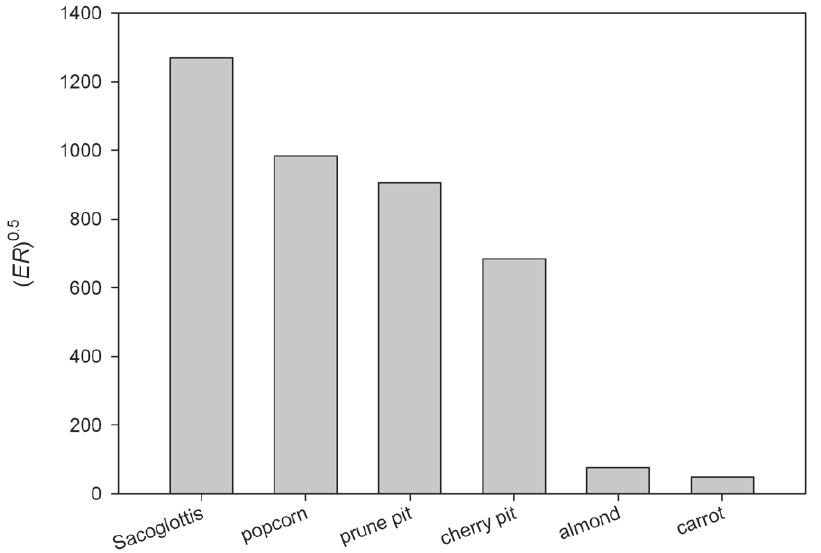
Figure 1. Fragmentation index of Sacoglottisgabonensis compared to familiar food materials. E is elastic modulus (MPa) and R is fracture toughness (Jm 2 2 ). High values indicate stress-limited foods, i.e., those expected to require high occlusal forces to induce structural failure. Sacoglottis is materially hard (high stiffness) but its ‘‘honeycombed’’ interior also renders it structurally tough. Comparative data are from ref 15.